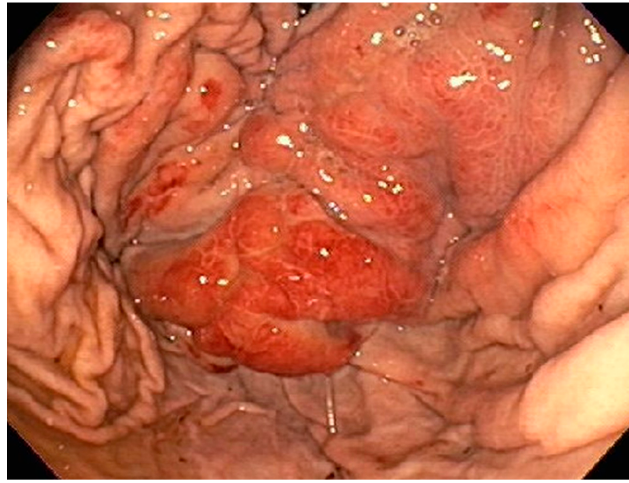
Figure 2. EGD revealing a large fungating gastric fundal mass.